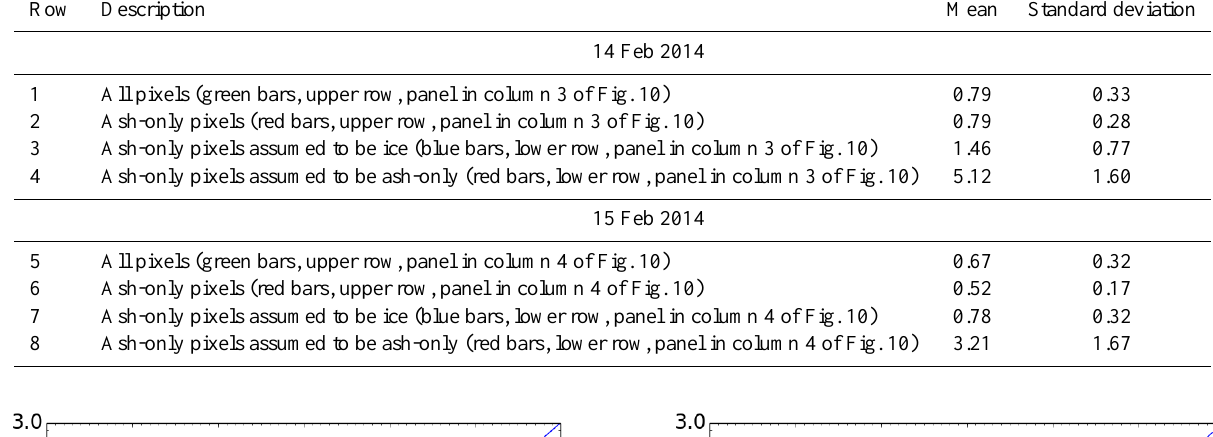
Ash-only pixels (red bars, upper row, panel in column 3 of Fig. 10) Ash-only pixels assumed to be ice (blue bars, lower row, panel in column 3 of Fig. 10) Ash-only pixels assumed to be ash-only (red bars, lower row, panel in column 3 of Fig. 10)